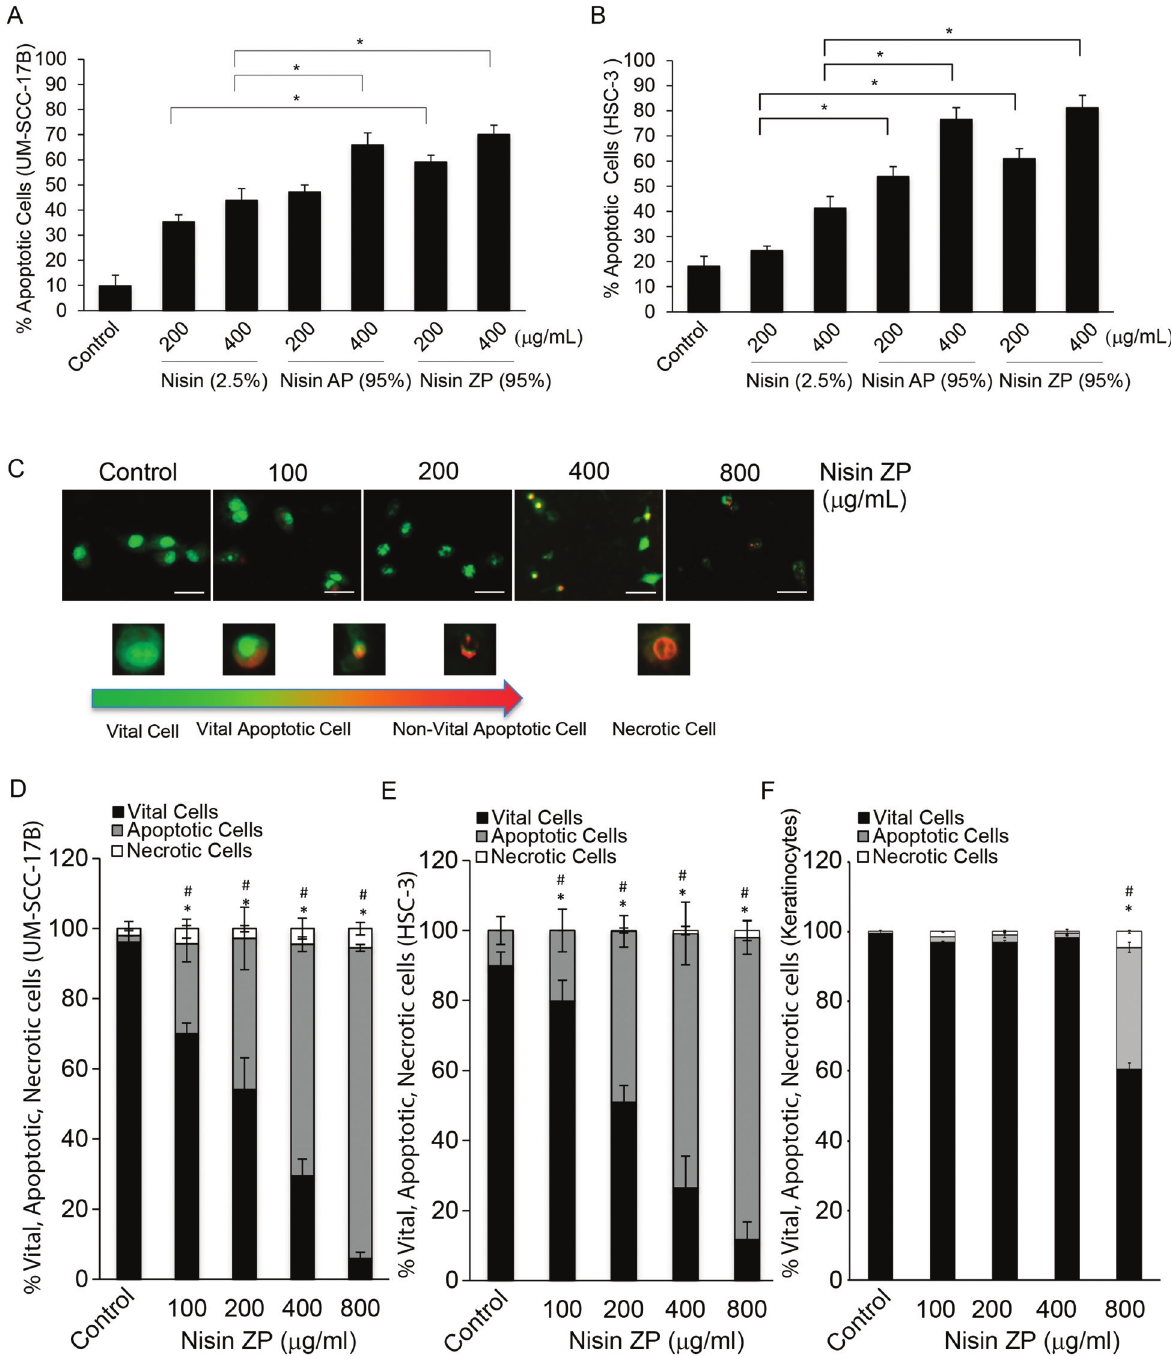
Fig 1. Nisin ZP and nisin AP induce significant HNSCC cell apoptosis dose-dependently and beyond that in low content nisin. A and B , Graphs showing changes in percentage of apoptotic HNSCC cells (HSC-3 and UM-SCC-17B) treated with control media or media containing 2.5% nisin, 95% nisin AP, or 95% nisin ZP for 24 h. Cells were then stained using an ethidium bromide and acridine orange (EB/AO) stain and counted. Comparisons between groups relative to controls were analyzed by ANOVA with the level of significance set at * p < 0.05. C , Microscopic images showing morphologhy of HNSCC cells treated with control media or media containing nisin ZP (100 to 800 μ g/mL) for 24 h then stained with EB/AO (Scale bars, 100 μ m). D-F , Graphs showing changes in percentage of vital, apoptotic, and necrotic cells (UM-SCC-17B, HSC-3 and normal oral keratinocytes) treated with control media or media containing nisin ZP (400 or 800 μ g/mL) for 24 h. Comparisons between groups relative to controls were analyzed by ANOVA with the level of significance set at * p < 0.05 vital cells; # p < 0.05 apoptotic cells.